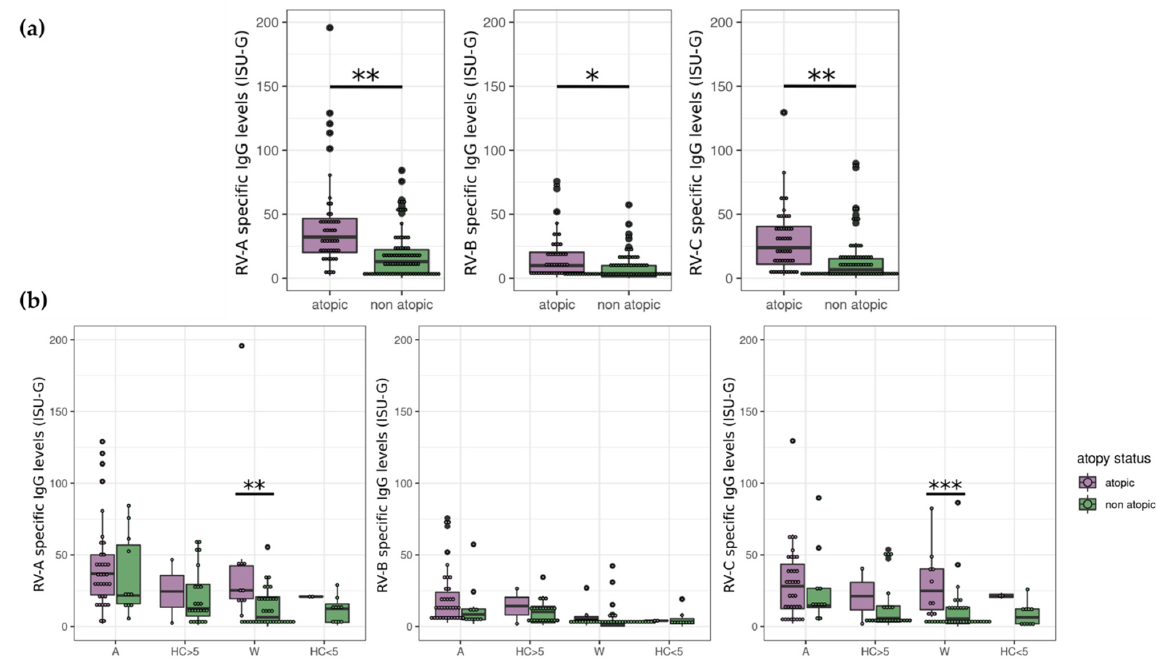
Figure 2. Rhinovirus (RV) species-specific antibody levels are higher in atopic subjects. The extent to which atopic status is associated with RV species was next hypothesized. ( a ) We observed that atopic patients had elevated IgG titers to RV-A, -B, and -C. For each RV species, the virus-specific IgG level of atopic and non-atopic participants was compared using T-tests. p -values were corrected using the FDR method. ( b ) Levels of IgG responses to RV-A, -B, and -C species in exacerbated asthmatics, wheezers, and their age-matched controls subdivided according to the atopy status (atopic: Violet; non-atopic: Green). For each species and each age group (older or younger than five years old), the influence on virus-specific IgG level of disease, atopy status, or interaction of both factors were tested using an ART (aligned rank transform) model (non-parametric equivalent of a 2-way ANOVA test). The p -values were corrected using the FDR method. In young patients, atopy was associated with higher RV-specific IgG levels of species A ( p = 0.016) and species C ( p = 0.030). Post-hoc pairwise comparisons (Mann–Whitney U tests) found significant differences between atopic and non-atopic patients in the wheezers group ( p = 0.0011 for A-species and p = 0.0009 for C-species), but not in young healthy controls. *: 0.01 < p < 0.05; **: 0.001 < p < 0.01; ***: p < 0.001. A: Asthmatics,